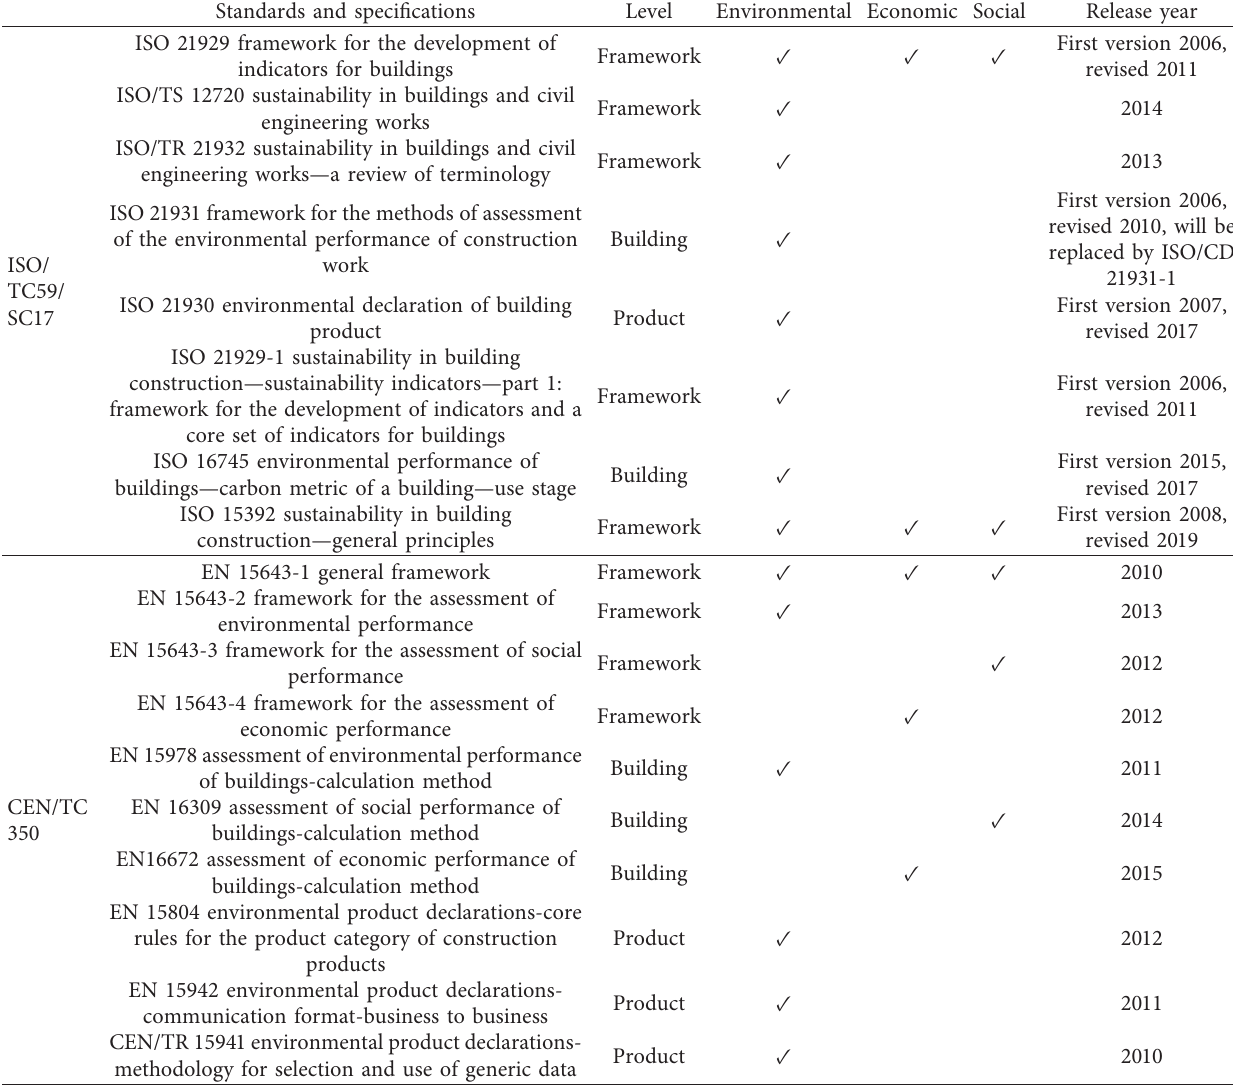
Table 1: Summary of sustainable standards and specifications for building